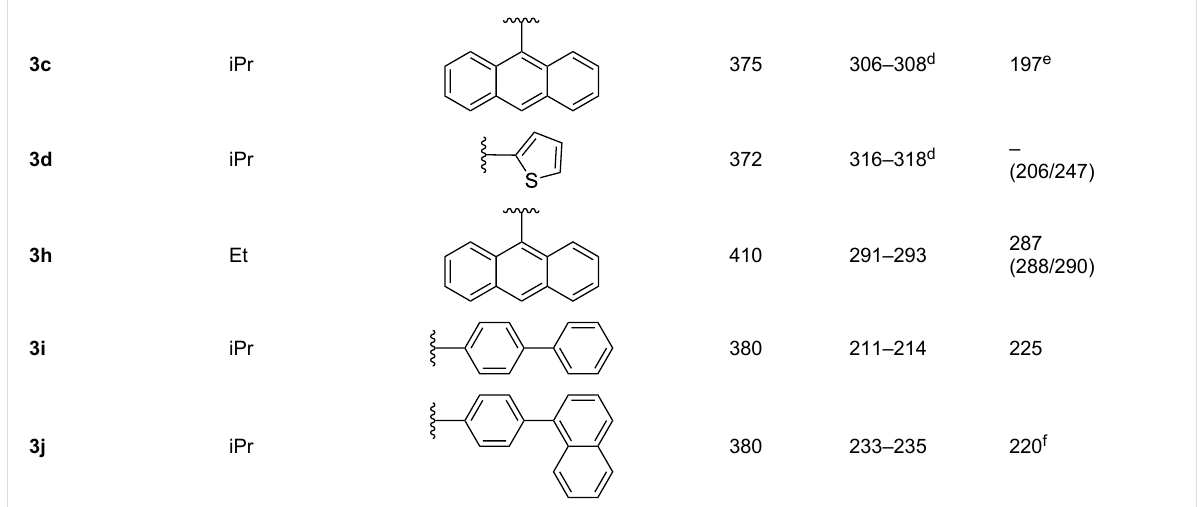
Table 2: Thermal properties of a representative selection of pentacenes.